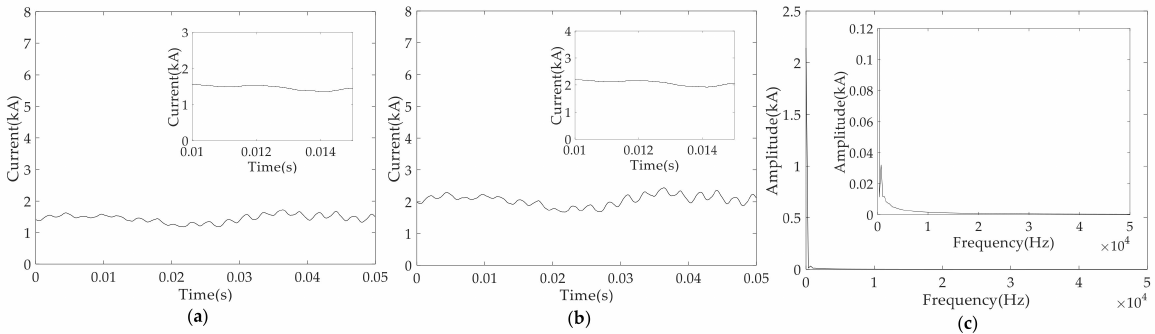
Figure 9. Fault characteristics of a sub-module short circuit fault (SMF) on the arm of a phase. ( a ) Current waveform; ( b ) current line mode component waveform; ( c ) spectrum analysis.